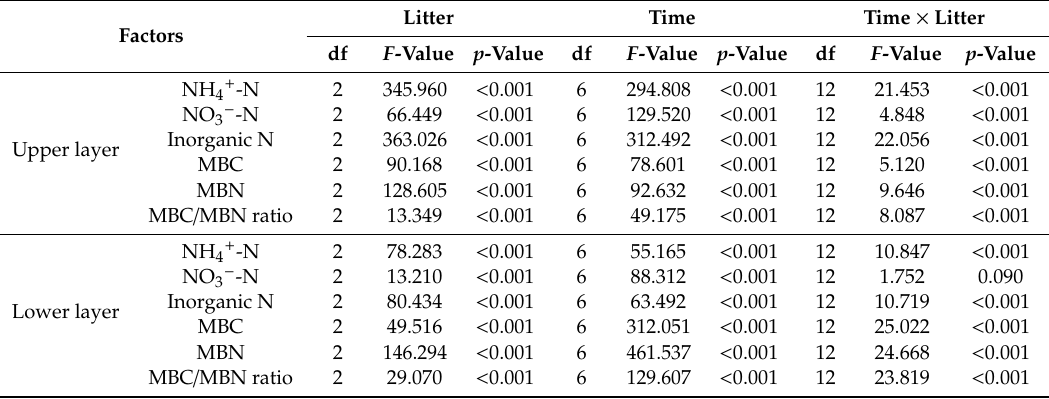
Table A1. Results of two-way repeated measures ANOVA concerning the e ff ects of sampling time, litter manipulation, and the interaction between sampling time and litter manipulation on the contents of soil NH 4 + -N, NO 3 − -N, inorganic N, MBC, MBN, and MBC / MBN ratio in the upper layer and the lower layer of the Larix gmelinii